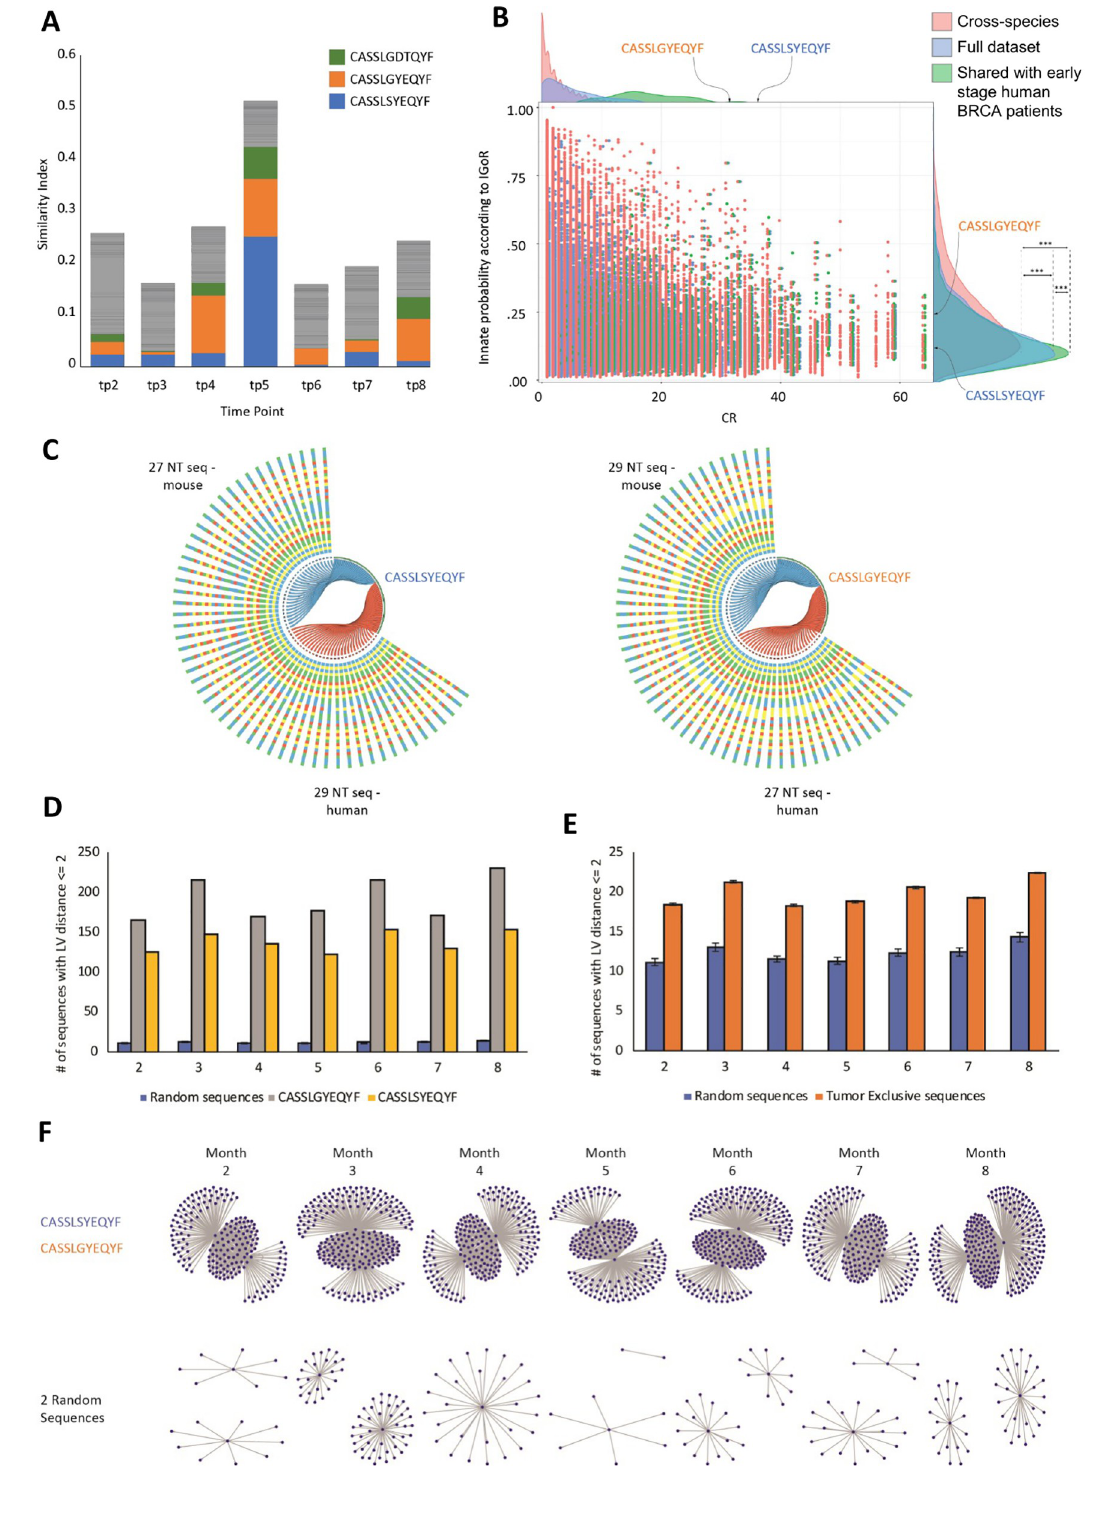
Fig 4. Specific Cross-species TCR β Clones Dominate the tumor-developing Group. (A) We ranked the 258 cross-species sequences according to their abundance in each sample. To visualize similarities between the ranking in each time point and the samples